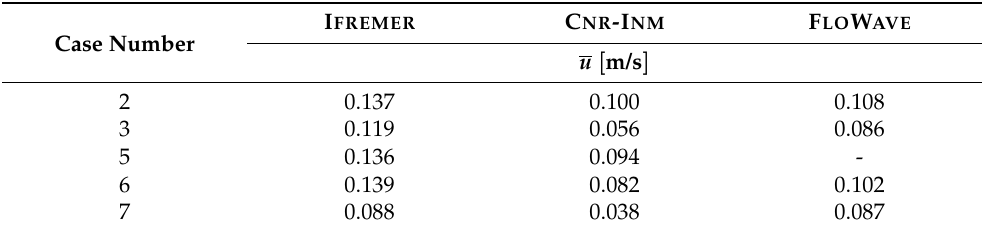
Table 7. Time-average of the horizontal wave orbitals u measured by the ADV at the turbine hub height for all cases at all facilities.